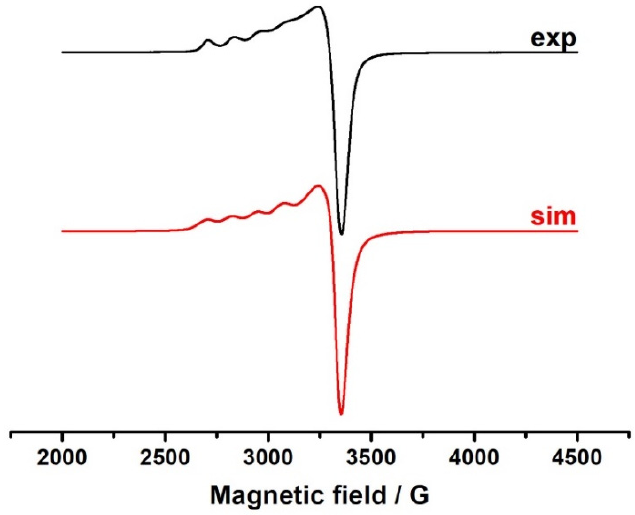
Figure 6. ESR spectrum of the PG-NaCu powder at a temperature of 150 K and its simulation. The parameters obtained from the simulation are shown